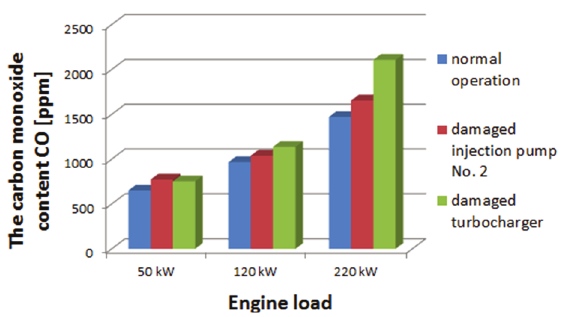
Fig. 5. The influence of engine load on the carbon monoxide CO [ppm] content indicated by the analyzer for various engine states